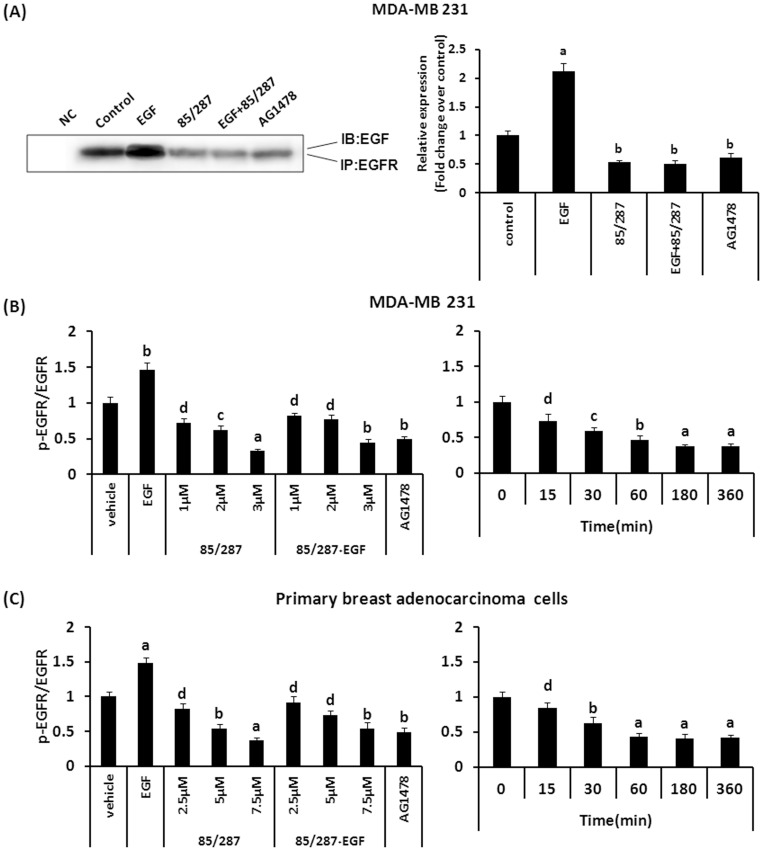
CDRI-85/287 inhibits EGF- EGFR interaction and antagonizes EGF- induced EGFR activation.(A) Effect on EGF-EGFR complex formation as determined by co-immunoprecipitation in MDA-MB 231 cells. Cells were incubated as shown in the figure for 48 h. Cell lysates were immunoprecipitated with anti-EGFR antibody and subsequently immunoblotted with anti-EGF. NC is the negative control. Left panel shows the representative blot showing EGF-EGFR complex and right panel shows the densitometric analysis of bands. The results are presented as mean± SEM of three independent experiments. p values are a-p<0.001, b-p<0.01, c-p<0.05 and d-p>0.05 vs. control. (B, C) Effect of CDRI-85/287 on EGFR activation was determined by ELISA. Cells were treated as indicated in the figure and analyzed for the expression of phosphorylated EGFR and total EGFR using ELISA kit as per manufacturer’s instructions. Activation of EGFR at different concentrations (left panel) and at various time points (right panel) in (B) MDA-MB 231 and (C) primary breast adenocarcinoma cells was determined by normalizing the expression of p-EGFR with EGFR. p values are a-p<0.001, b<0.01, c-p<0.05 and d-p>0.05 vs. control.